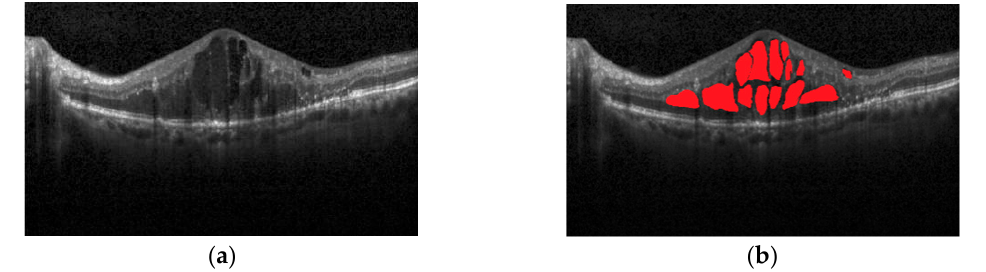
Figure 1. OCT image with macular edema and annotated image of edema area in OCT image: ( a ) OCT image with macular edema; ( b ) the annotations of the edema regions.